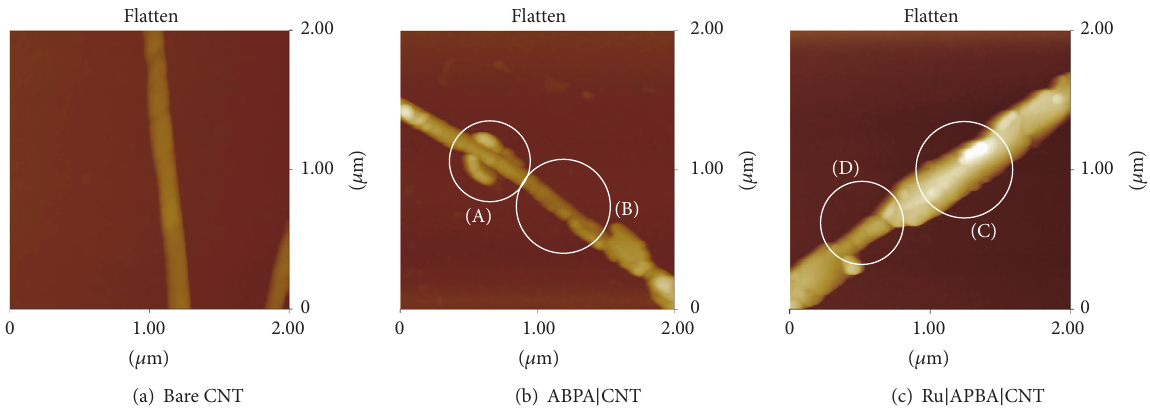
Figure 6: AFM images of bare CNT, ABPA | CNT, and Ru | APBA | CNT.